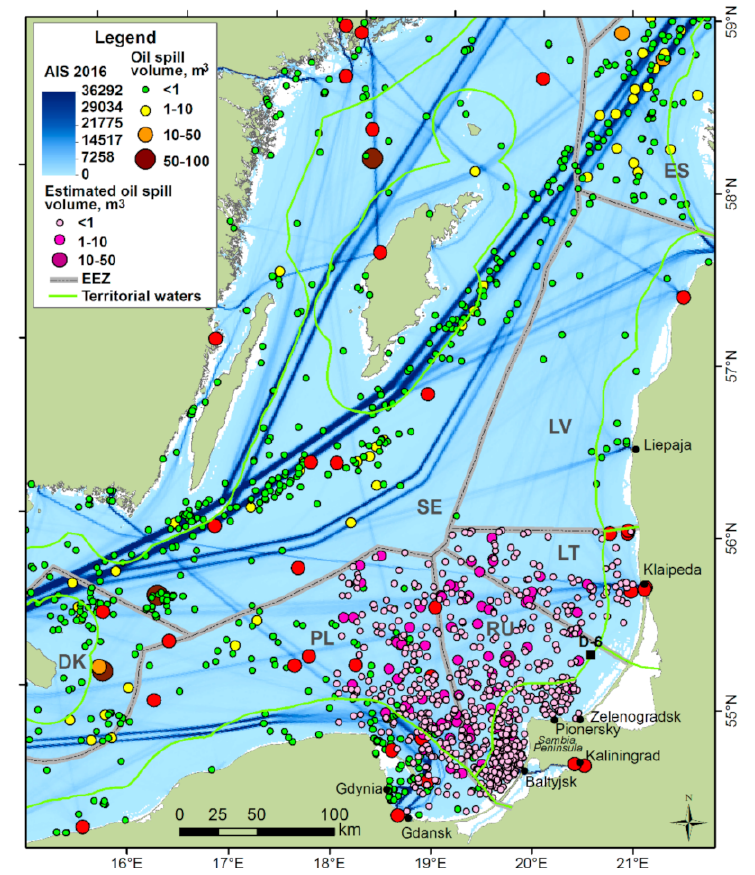
Figure 13. Volume of illegal oil discharges observed during aerial surveillance flights by the HELCOM Contracting Parties during 2004–2017 and the estimated volume of oil discharges revealed by satellite data during 2004–2017 in the study area. The intensity of the ship traffic is shown in blue, based on the AIS signals in 2016 according to HELCOM